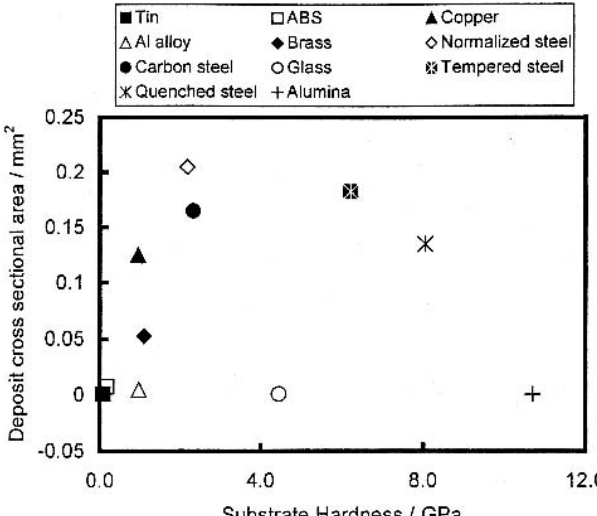
Figure 7: The relationship between surface hardness and deposition efficiency in different substrate [34].